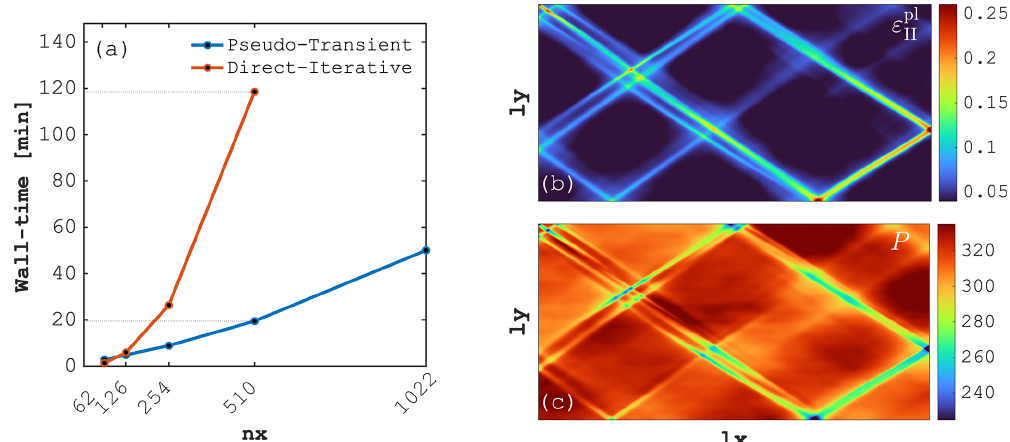
Figure 15. Performance comparison between the pseudo-transient (PT) and direct-iterative (DI) method resolving 2D shear-band formation out of a random noise cohesion field. (a) Wall time in minutes as a function of numerical grid resolution in x direction ( lines connect wall times for n x = 510 from both solvers. Panels (b) and (c) depict total accumulated plastic strain ε pl respectively, from the 1022 × 1022 resolution 2D PT-GPU simulation.